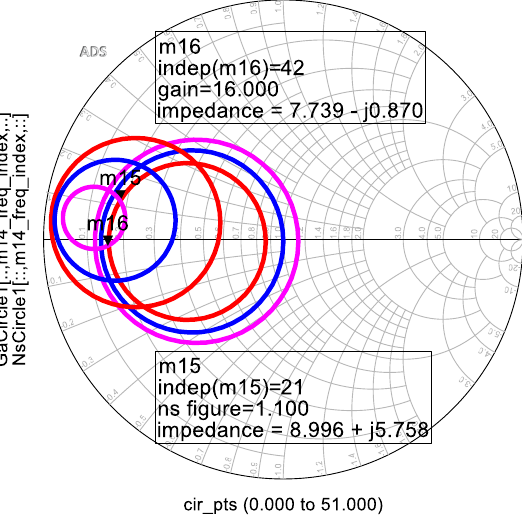
Fig. 9. Input impedance value for different noise figure and gain values using gain and noise figure circles